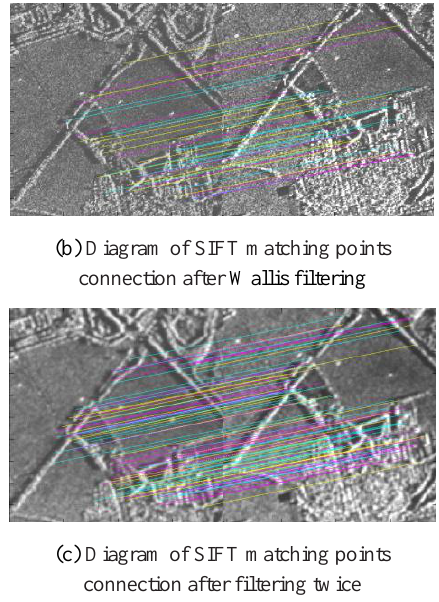
Figure 2. The matching result of SIFT algorithm to the enhanced